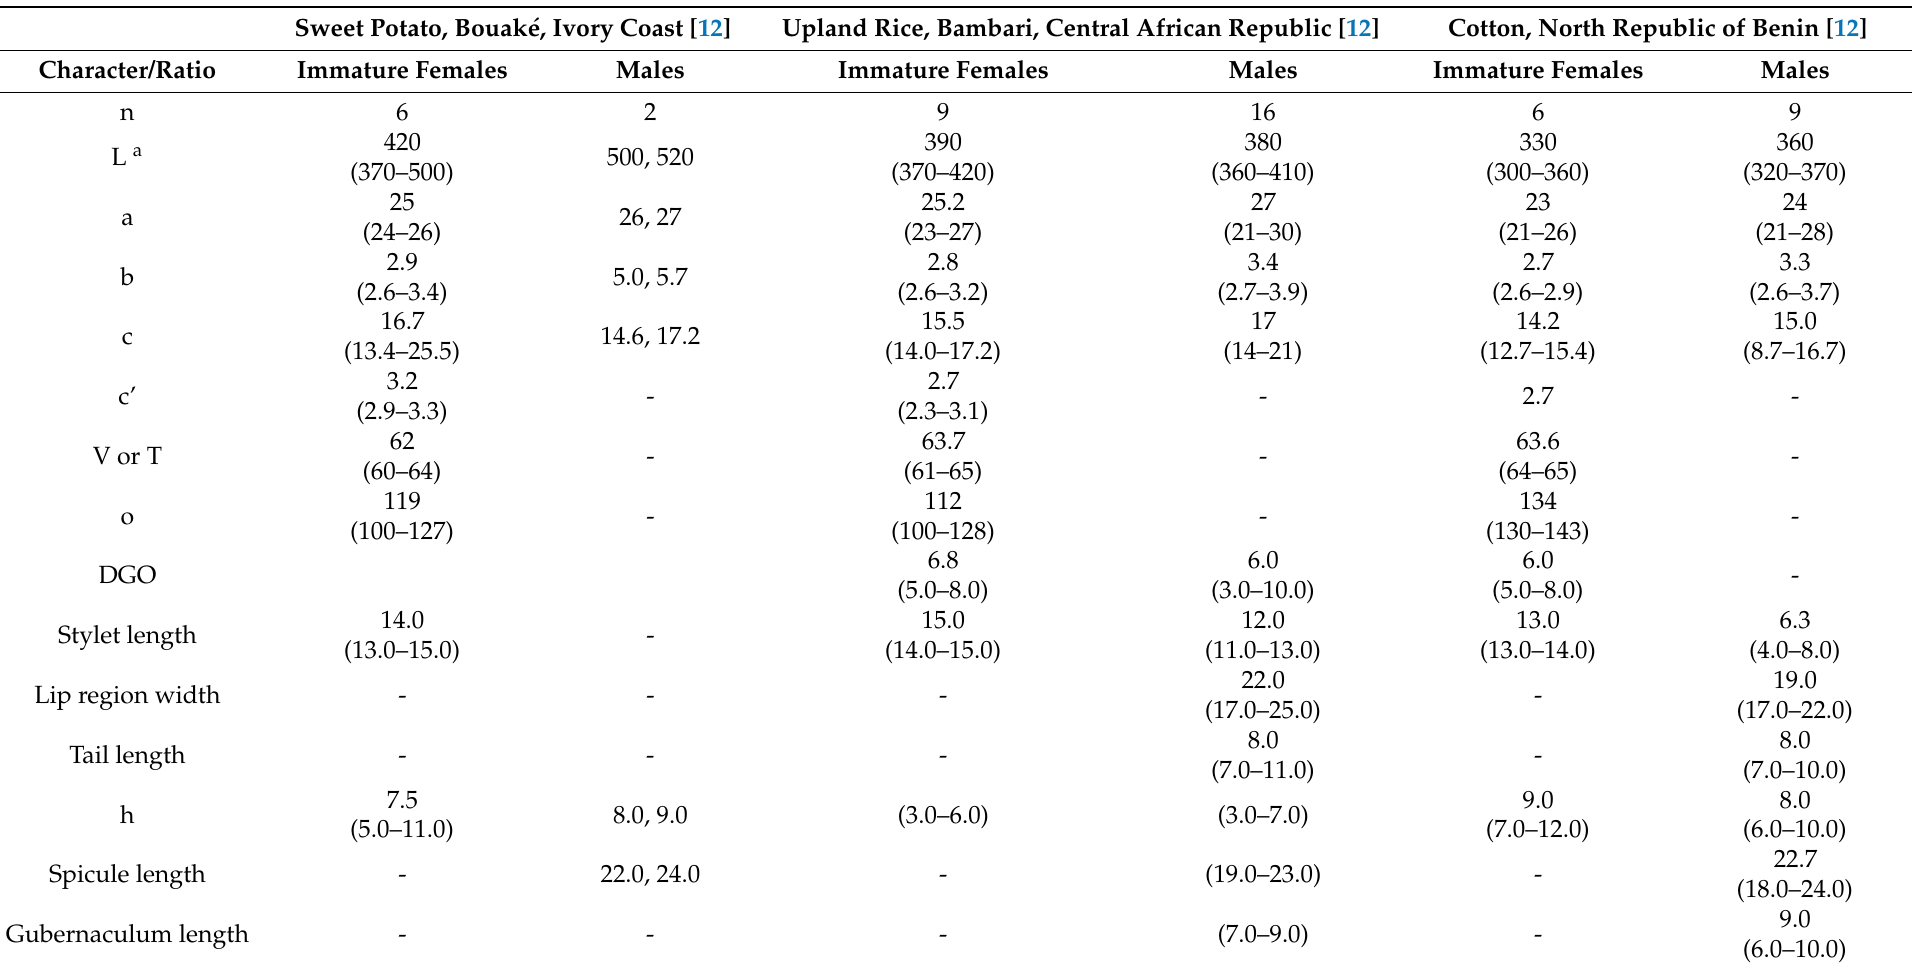
Table 3. Measurements of immature females and males of Rotylenchulus borealis from several localities in Africa. All measurements are in micrometers and in the form mean ± SD